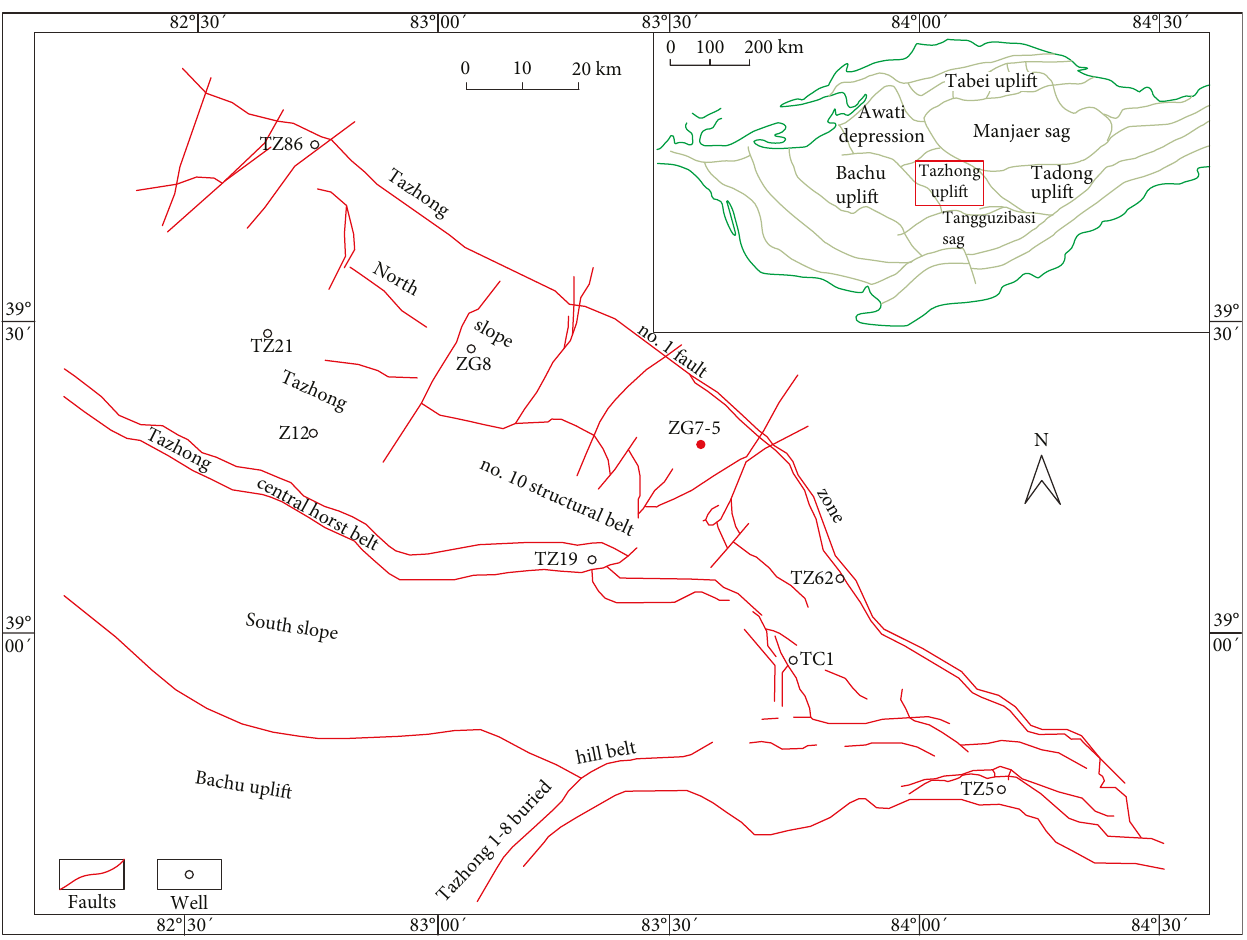
Figure 1: Map showing the location of Well ZG7-5 and the geological structures in the Tazhong Uplift (modi fi ed from [19]).